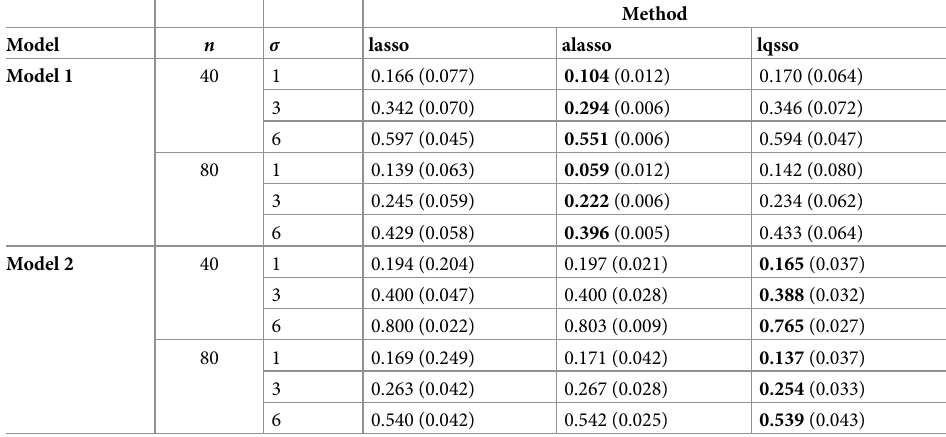
Table 2. The mean values of bias for Model 1 and Model